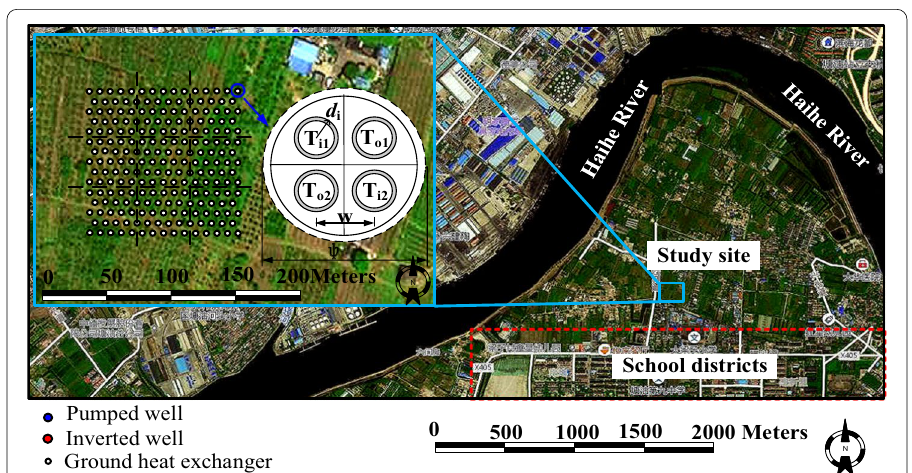
Fig. 2 Location of study site in Tianjin, China, in 2016 and plan view of BHEs